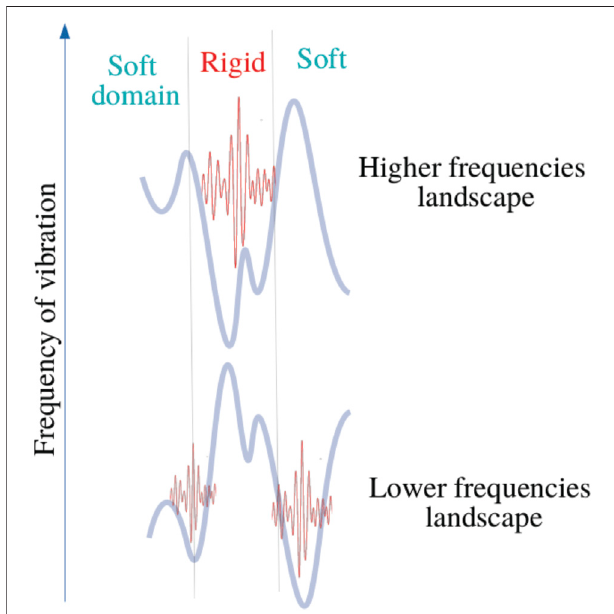
FIGURE 3 | Effective con fi nement